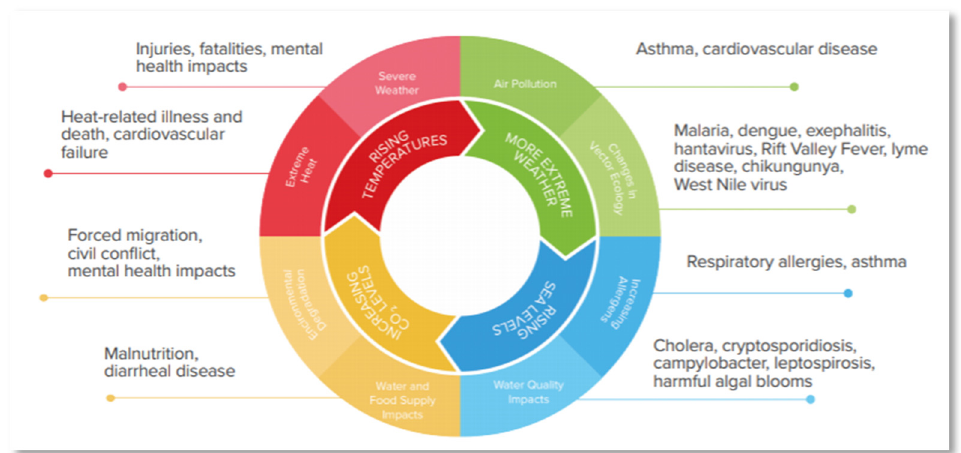
Figure 1. Impact of climate change on human health [2] (Original source: U.S. Centres for Disease Control and Prevention).